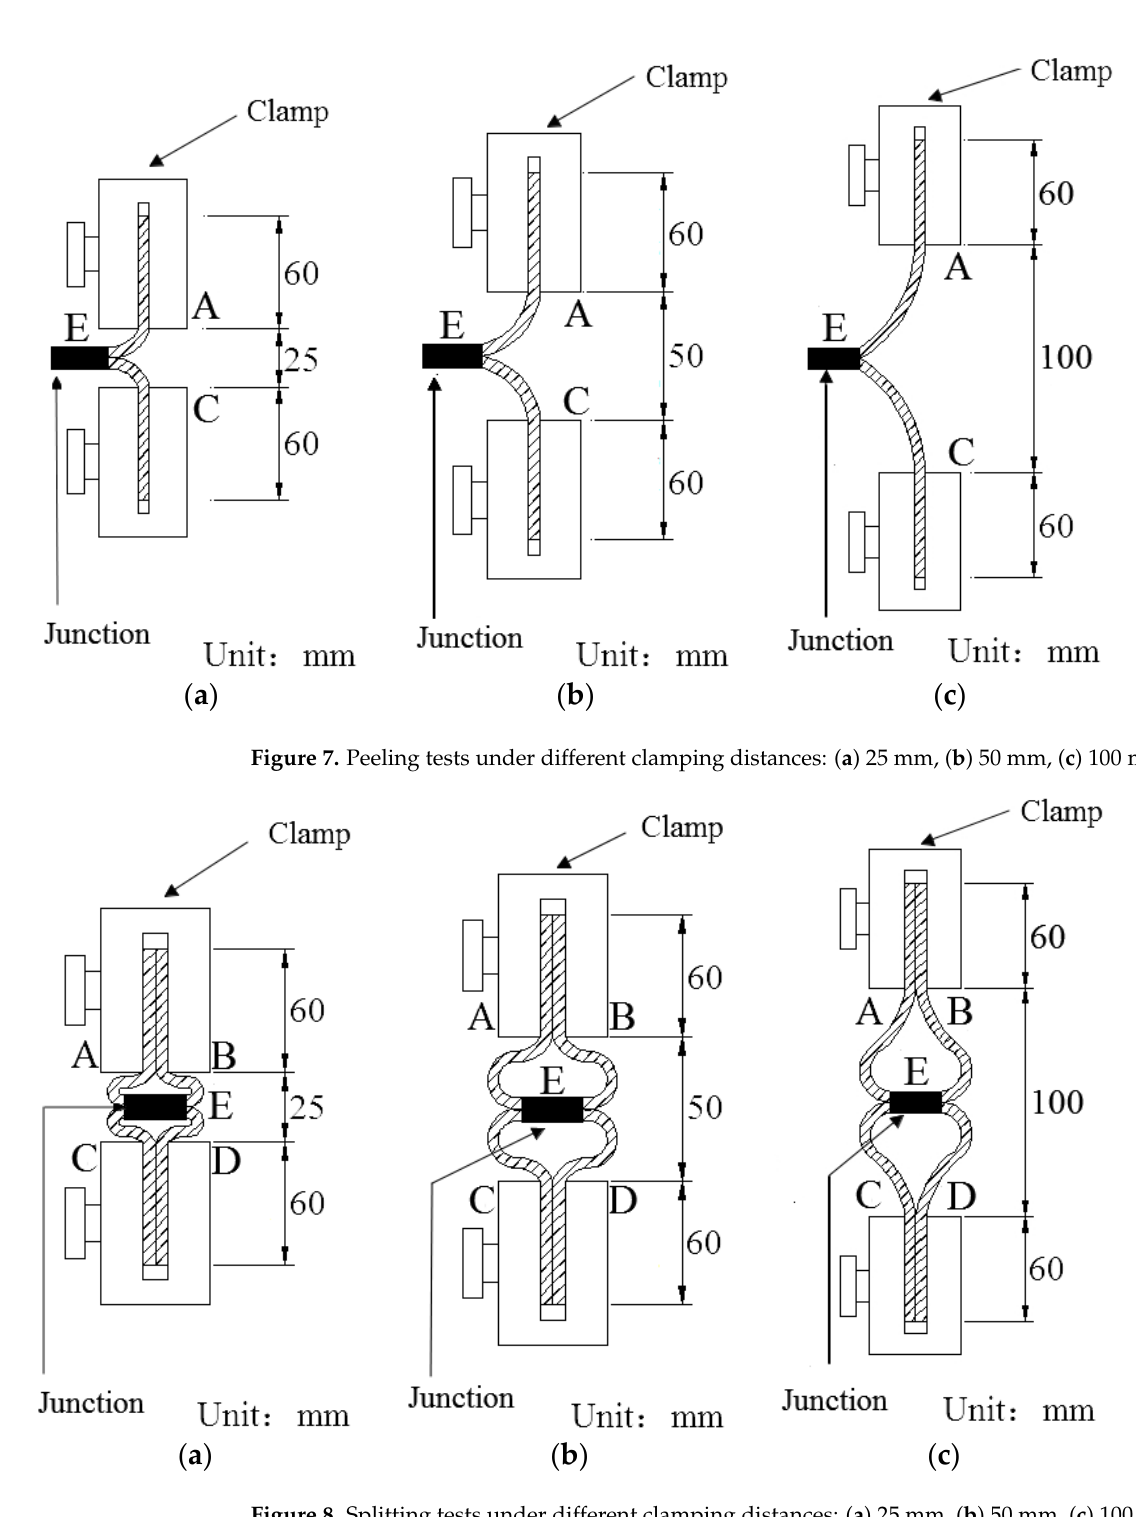
Figure 8. Splitting tests under different clamping distances: ( a ) 25 mm, ( b ) 50 mm, ( c ) 100 mm.